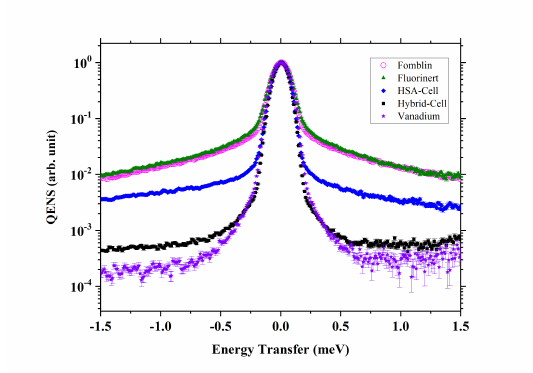
Fig. 5. QENS contributions from the pressure cells and several other materials as described in the text.